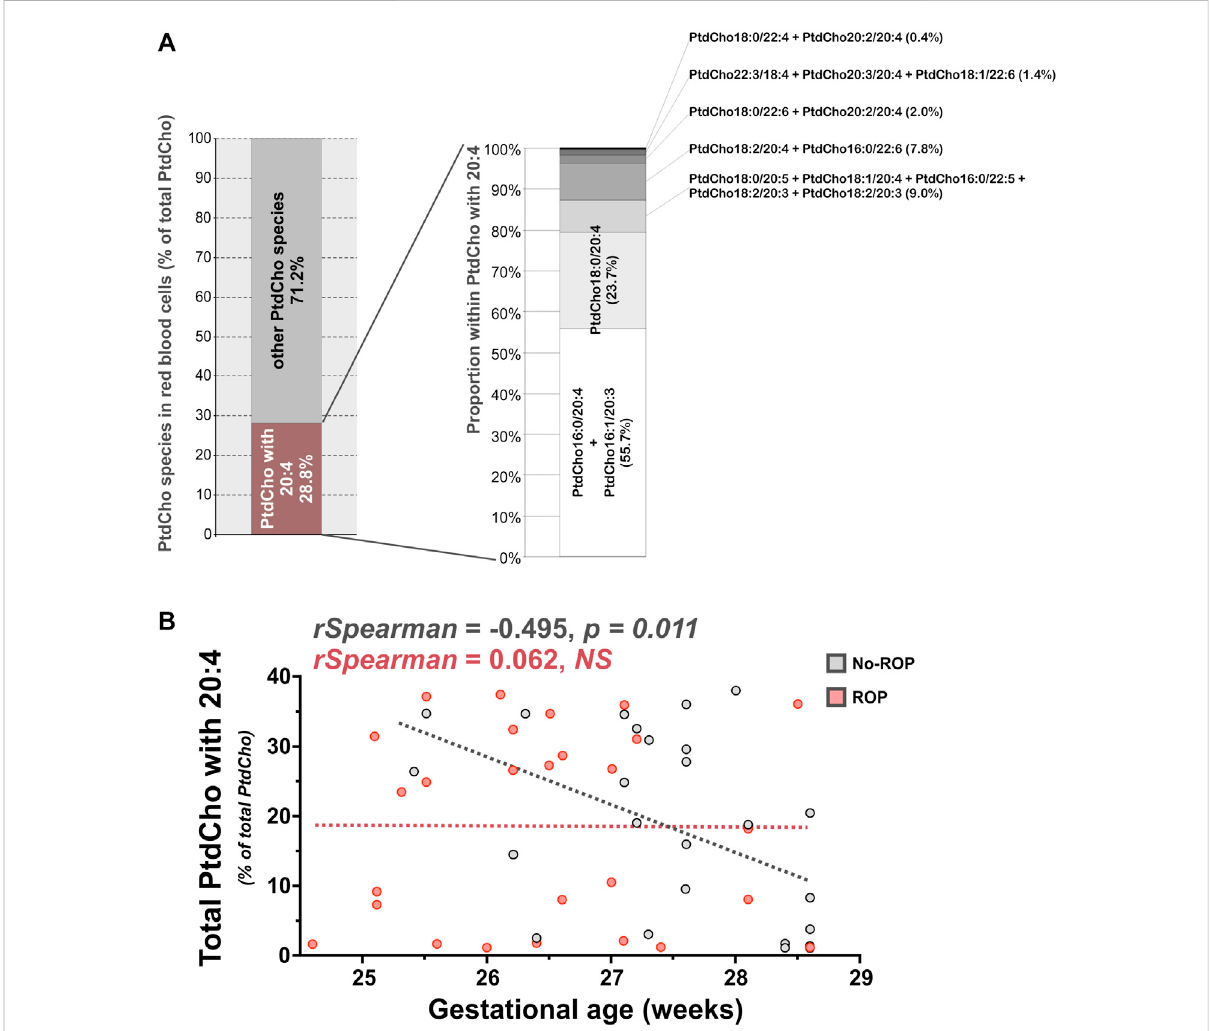
FIGURE 2 PtdChowithARAareassociatedwithGAinpreterminfantswithoutROP. (A) PtdChowithARA(20:4)accountedfor28.8%oftotalretinalPtdCho species. (B) The sum of PtdCho species carrying ARA was negatively associated to GA in erythrocytes of preterm infants of the no-ROP group (rho = − 0.495, p = 0.011). Abbreviations of individual PtdCho species are as follows: Position on the glycerol backbone as shown as sn-1/sn-2 of the fatty alcohol radicals (abbreviated as number of carbons: Number of double bonds). PtdCho: Phosphatidylcholine; ROP: Retinopathy of